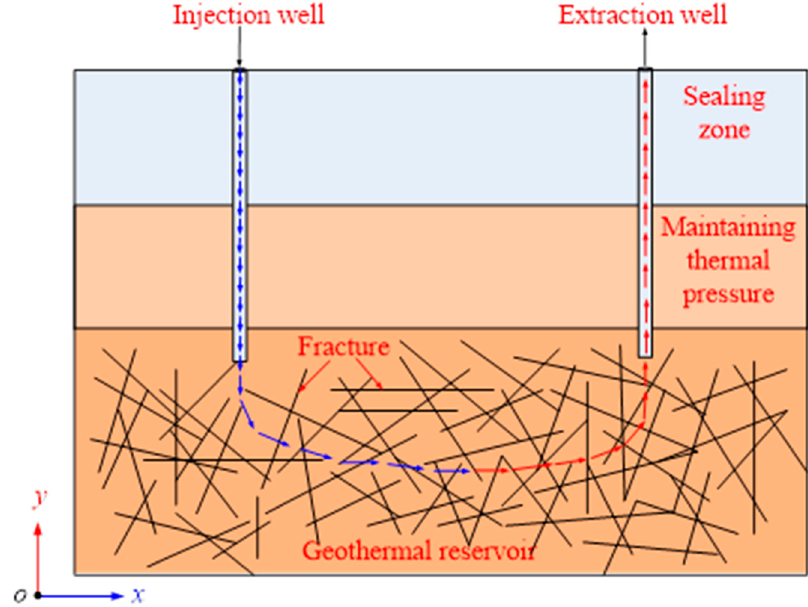
Figure 1. Schematic illustration of heat extraction from a geothermal reservoir.